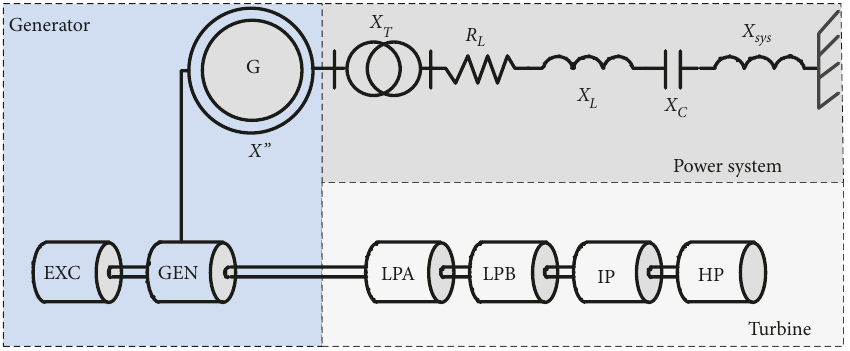
Figure 4: Electromechanical power